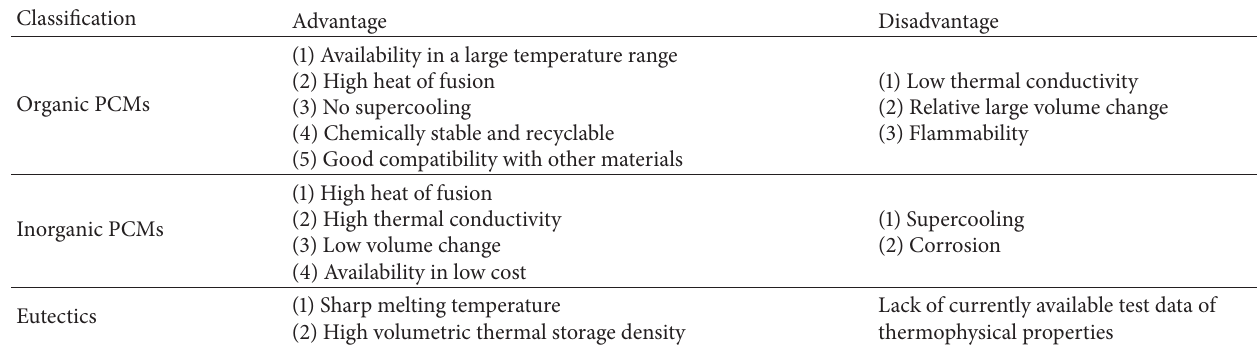
Table 1: Advantages and disadvantages of PCMs [7].